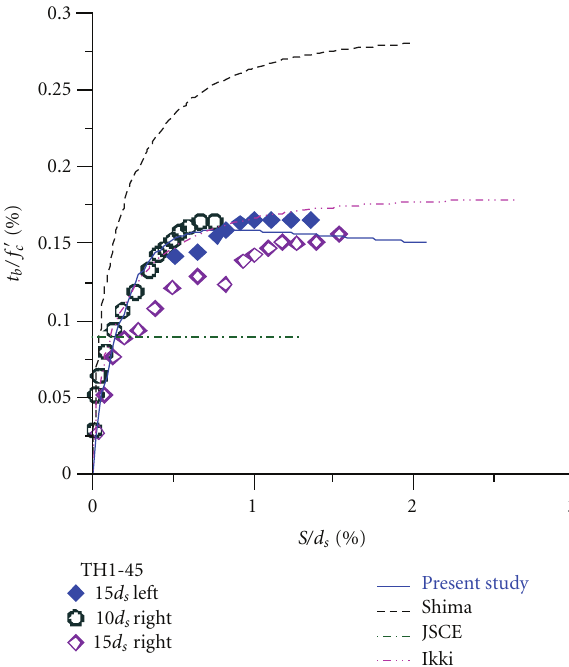
where E s : Young’s modulus of the bar, dε s / dx : slope of the strain distribution curve.